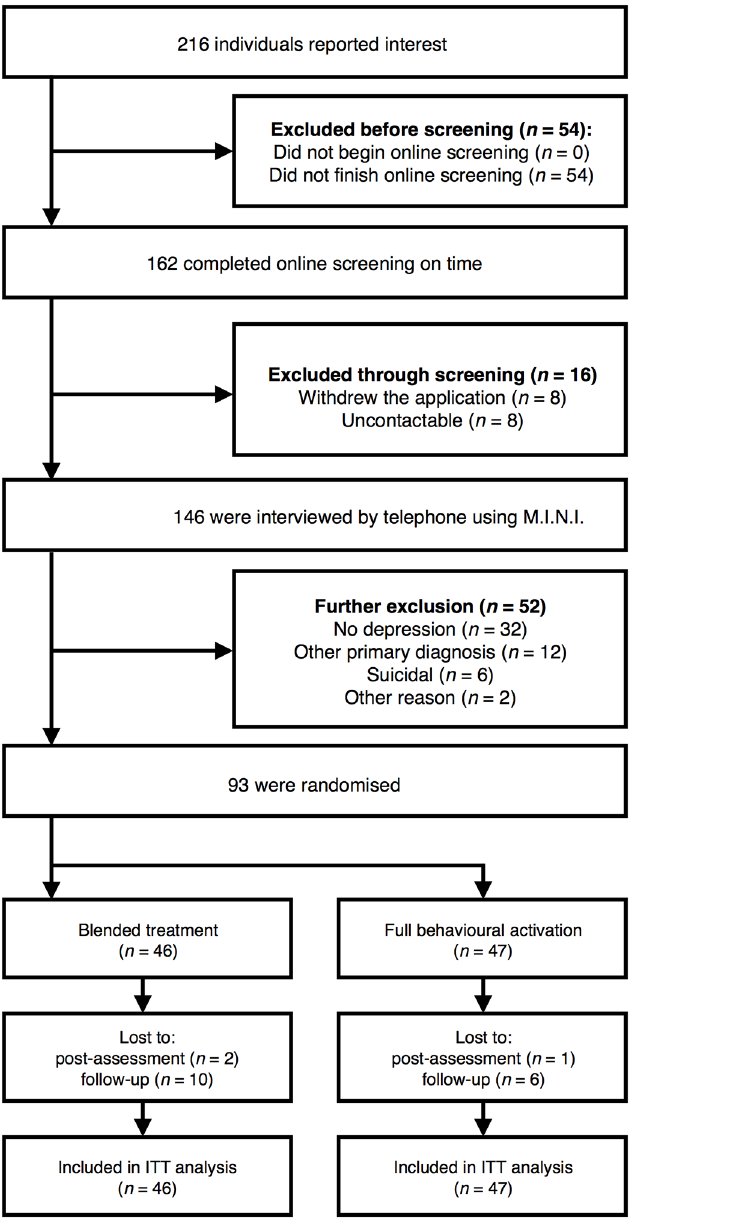
Fig 1. Participant flow and reasons for dropping out throughout the